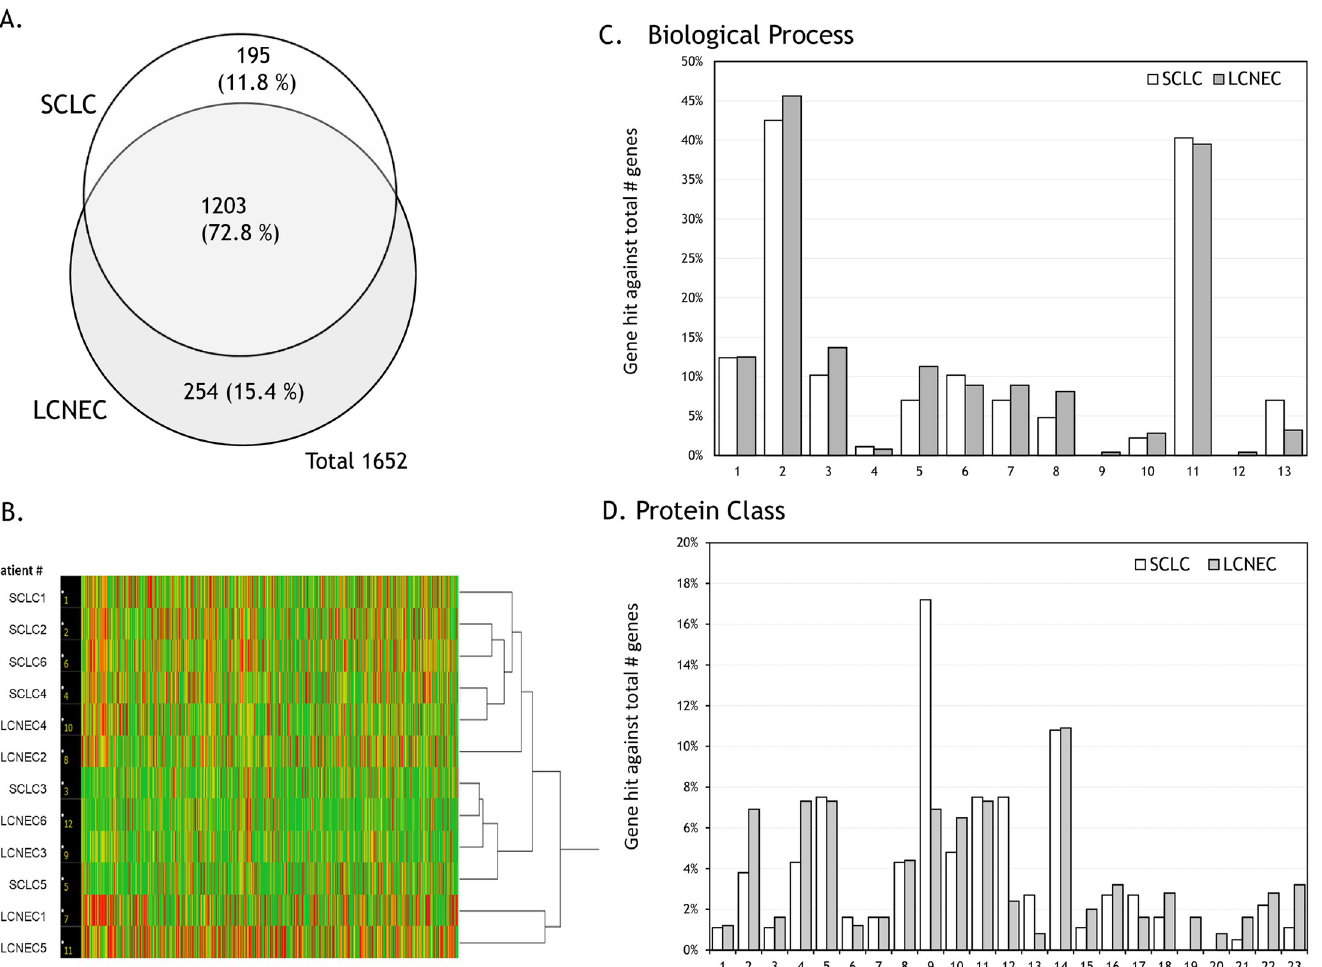
Fig 1. A Venn map, hierarchical clustering, and gene ontology (GO) analysis of the identified proteins. A. Venn map of identified proteins. B. A hierarchical clustering of the expressed proteins using the Ward method including their spectral counts for patients. C. Biological processes: 1, cellular component organization or biogenesis (GO:0071840); 2, cellular process (GO:0009987); 3, localization (GO:0051179); 4, reproduction (GO:0000003);5, biological regulation (GO:0065007); 6, response to stimulus (GO:0050896); 7, developmental process (GO:0032502); 8, multicellular organismal process (GO:0032501); 9, locomotion (GO:0040011); 10, biological adhesion (GO:0022610); 11, metabolic process (GO:0008152);12, growth (GO:0040007); 13,immune system process (GO:0002376). D. Protein classes: 1, extracellular matrix protein (PC00102); 2, cytoskeletal protein (PC00085); 3, transporter (PC00227); 4, transferase (PC00220); 5, oxidoreductase (PC00176); 6, lyase (PC00144); 7, cell adhesion molecule (PC00069); 8, ligase (PC00142); 9, nucleic acid binding (PC00171); 10, signaling molecule (PC00207); 11, enzyme modulator (PC00095); 12, calcium-binding protein (PC00060); 13, defense/immunity protein (PC00090); 14, hydrolase (PC00121); 15, transfer /carrier protein (PC00219);